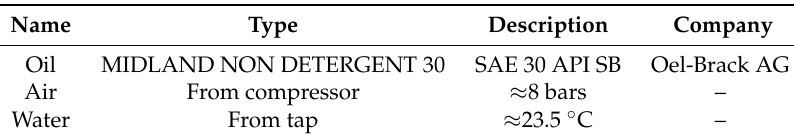
Table 2. Description of chemicals used for the hydrocyclone